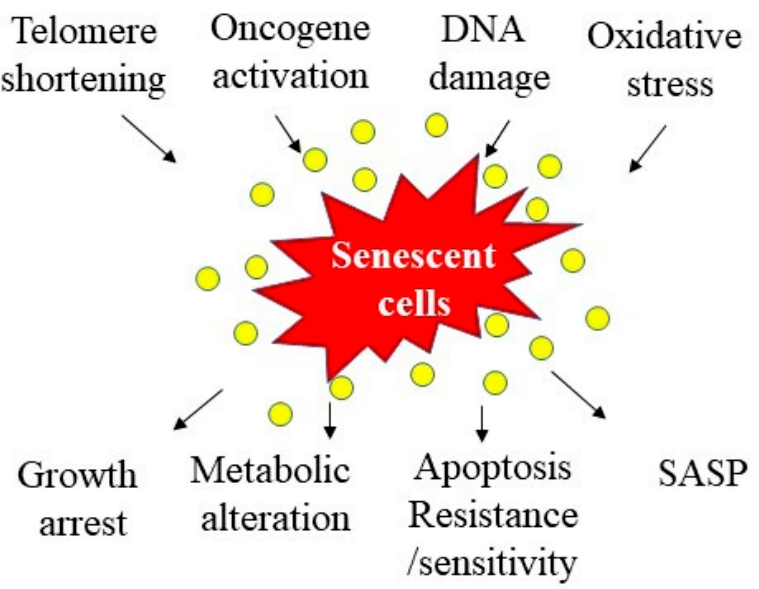
Figure 1. Potential causes and consequences of cell senescence. Several factors have been identified to induce cell senescence, including telomere shortening, oncogene activation, DNA damage, and oxidative stress. Senescent cells, on the other hand, exhibit multiple characteristics, including growth arrest, metabolic changes, altered apoptosis sensitivity, and senescence-associated secretary phenotype (SASP).